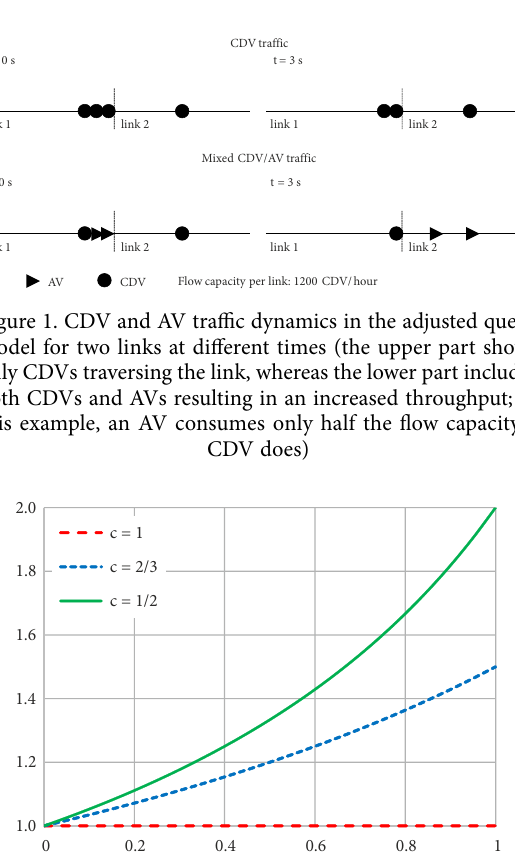
Figure 2. Flow capacity increase ratio of a link as a function of the AV share s for selected AV flow capacity consumption factors c